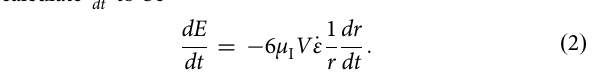
Table 1. The tactoids of both systems also illustrate single exponential decay during the shape relaxation like BLG I in Fig. 2a – c. The results for characteristic shape relaxation time of BLG II and SCNC show very good agreement with Eq. 1